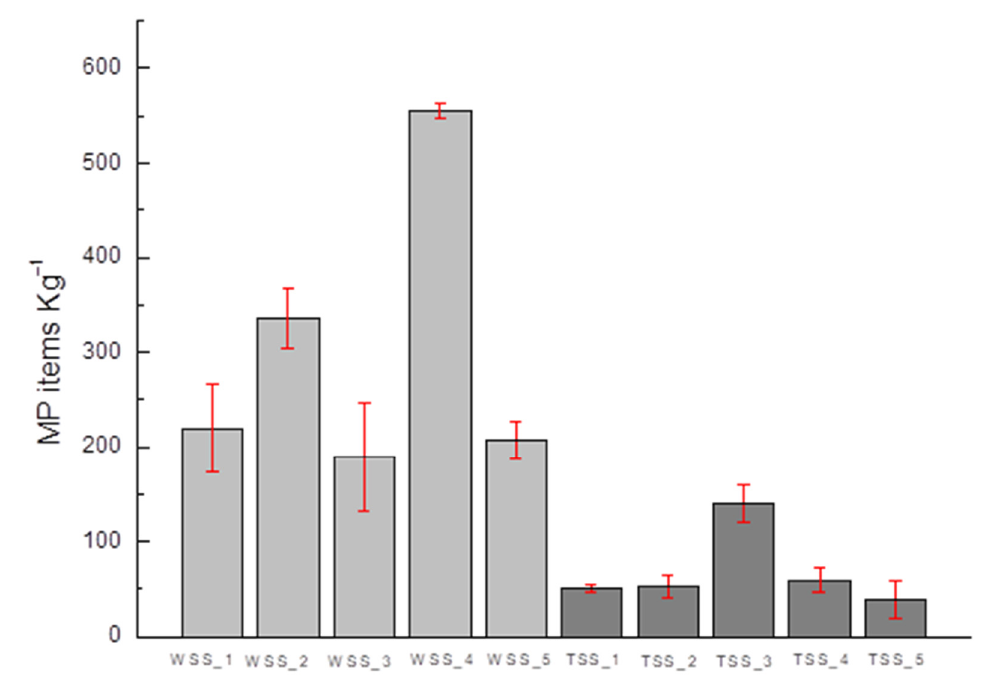
Figure 6. Average microplastic abundance in each